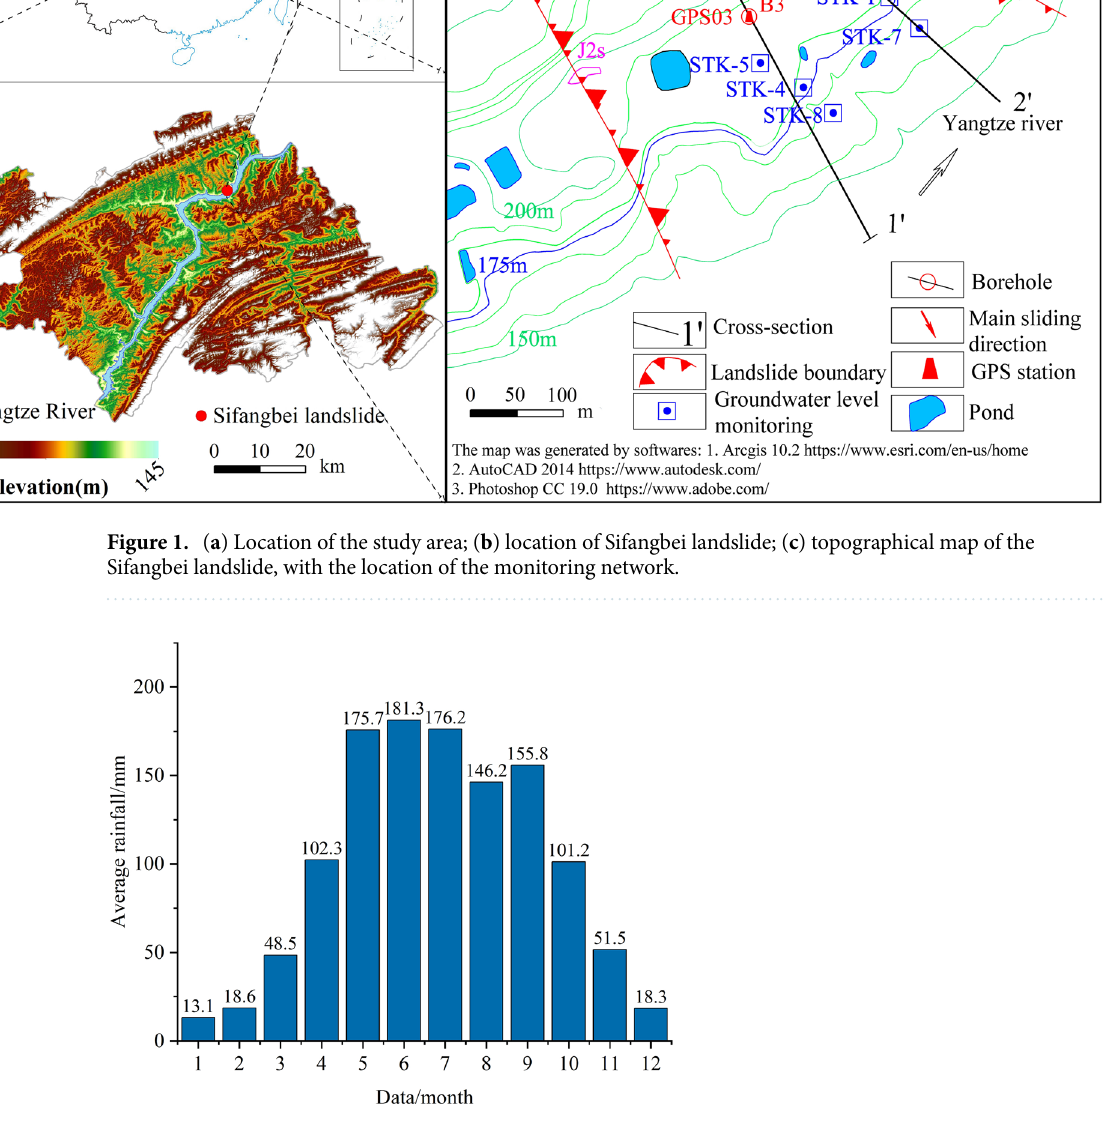
Figure 2. Average monthly rainfall in Wanzhou District